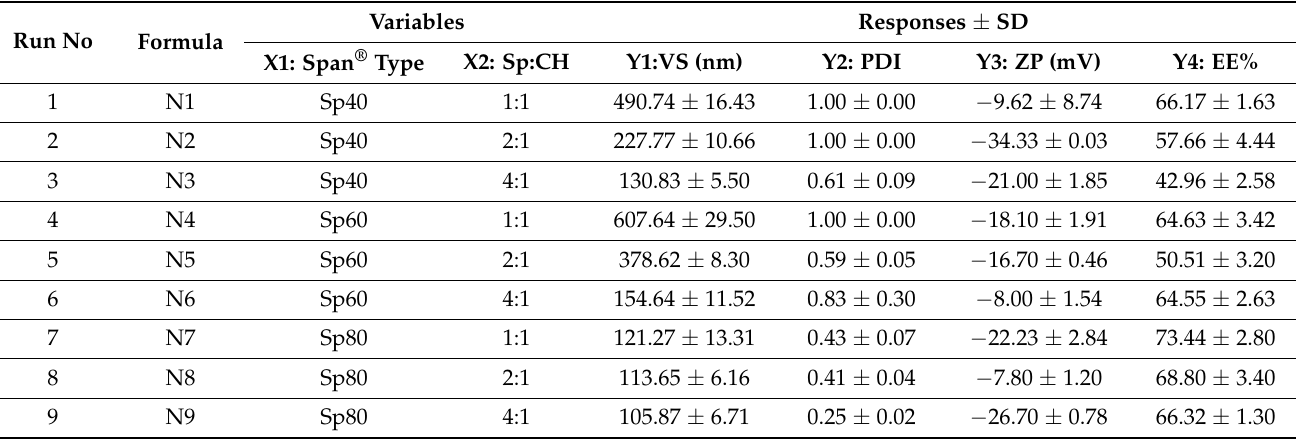
Table 3. Independent variables and measured responses of 3 2 full factorial design of DRN loaded